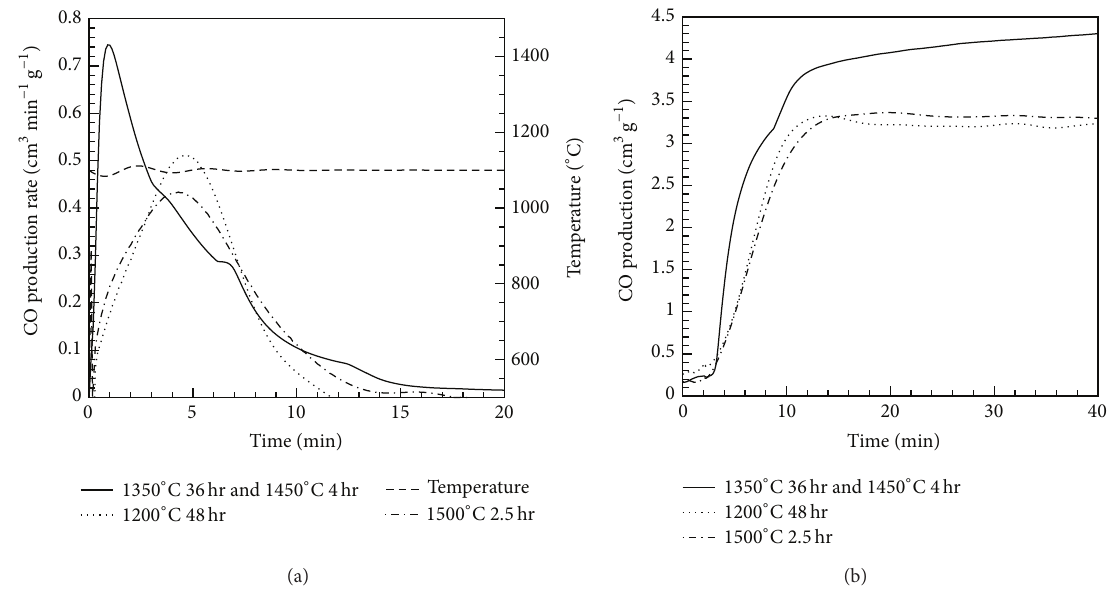
Figure 7: CO production (a) rate and (b) yield versus time during the oxidation step of the 4th cycle.